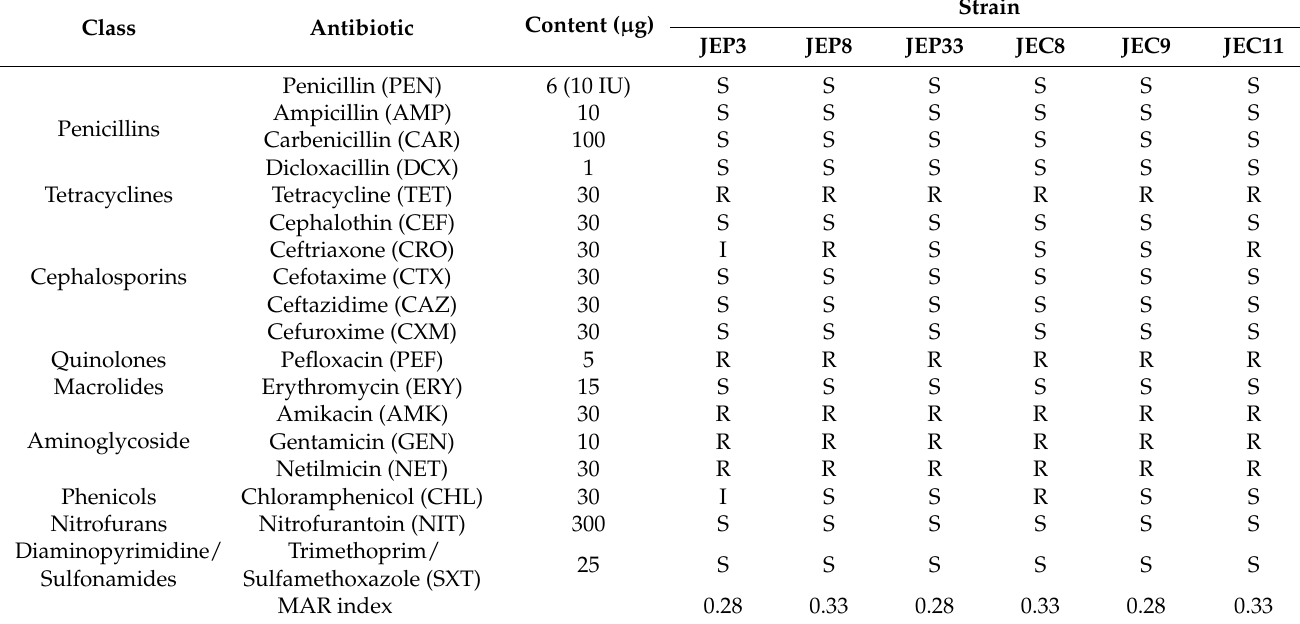
Table 2. Antibiotic test of endophytic bacteria from T. latifolia